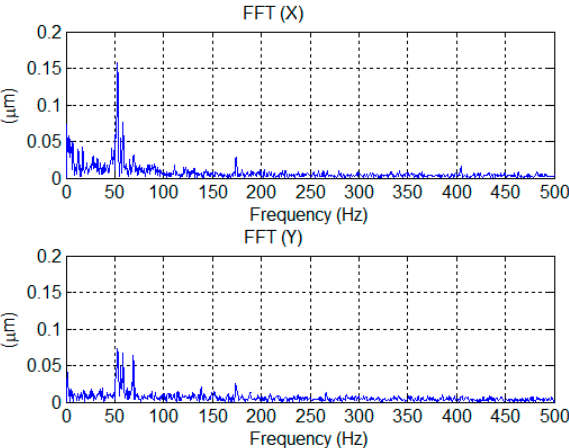
Figure 13. PSD output signals based on DC regulator.